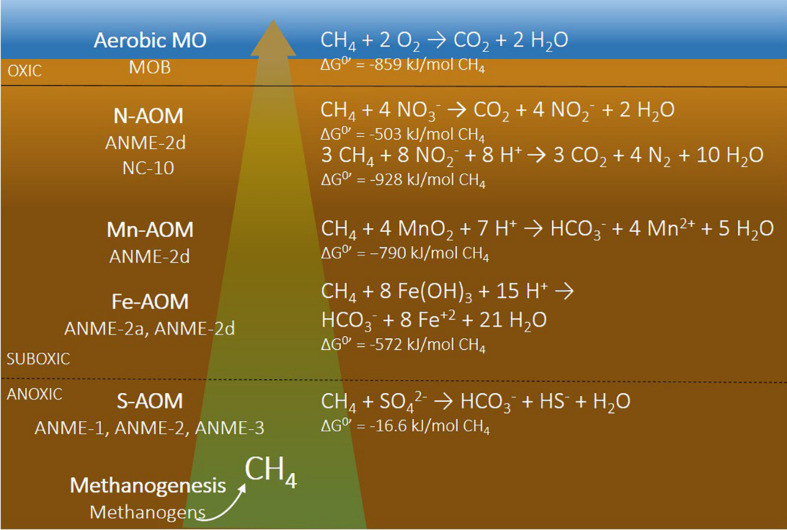
Schematic presentation of microbial processes and microorganisms (left) and reaction equations with different electron acceptors (right) involved in methane cycling. N-AOM can couple either nitrate (ANME-2d) or nitrite (NC-10) to methane oxidation. MO, methane oxidation; N-AOM, nitrate/nitrite-dependent anaerobic oxidation of methane; Mn-AOM, manganese-dependent anaerobic oxidation of methane; Fe-AOM, iron-dependent anaerobic oxidation of methane; S-AOM, sulfate-dependent anaerobic oxidation of methane. References for the Gibbs free energies are the following: aerobic MO (Regnier et al., 2011), N-AOM (In’ t Zandt et al., 2018), Mn-AOM and Fe-AOM (Sturm et al., 2019), and S-AOM (Meulepas et al., 2010).